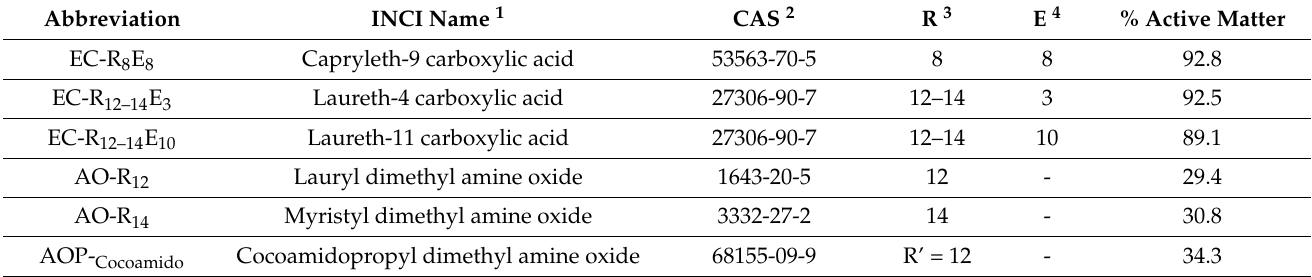
Table 1. Chemical identification and technical specifications of the surfactants tested.